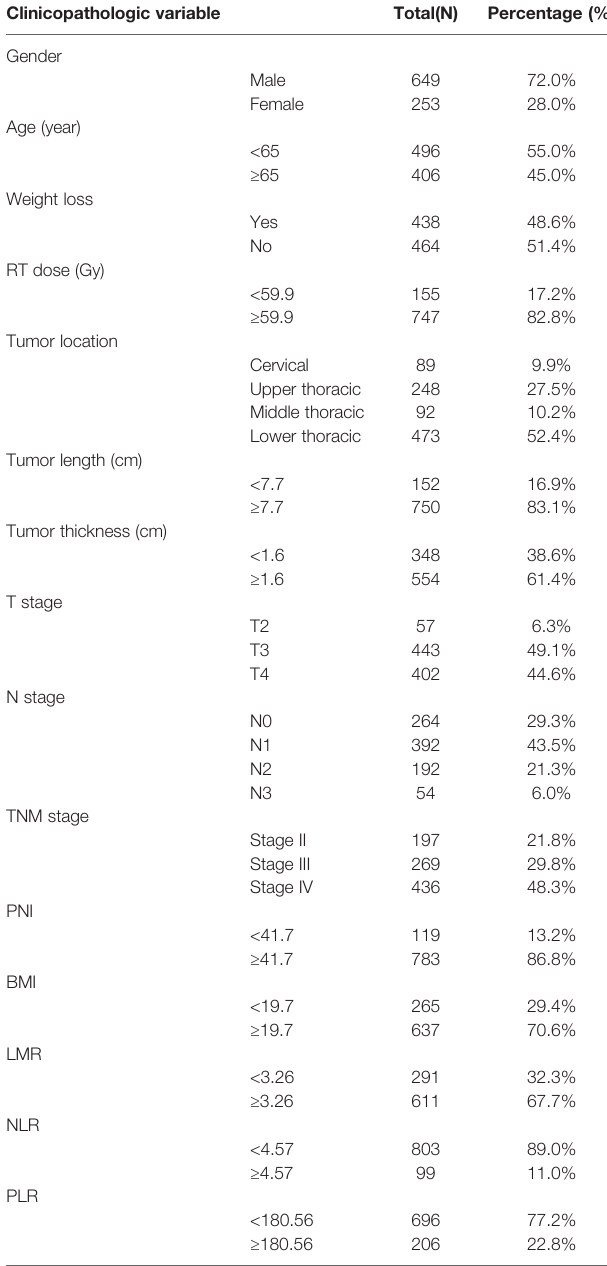
TABLE 1 | Clinical characteristics of 902 ESCC